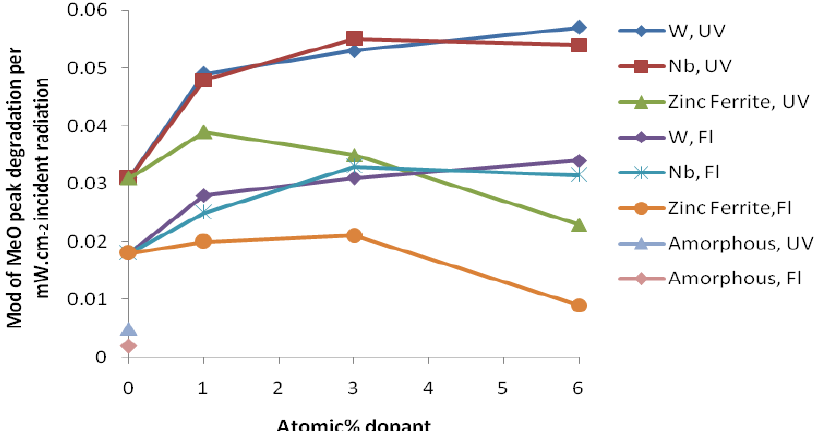
Figure 5. Comparison of normalized methyl orange degradation rates by titania coatings as a function of dopant content, sputtering process and lamp